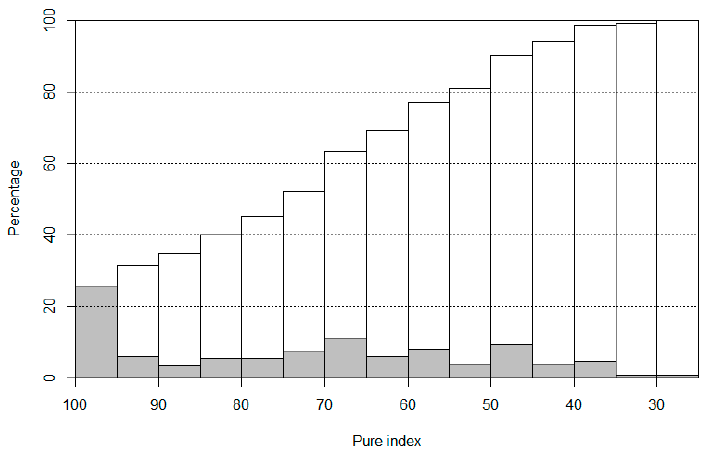
Figure 7. Percentage (shown in grey bars) and cumulative percentage (shown in white bars) of land use parcels at each degree of mixture as indicated by pure index. Table 5. Confusion matrices of urban land use classification using mixed and pure